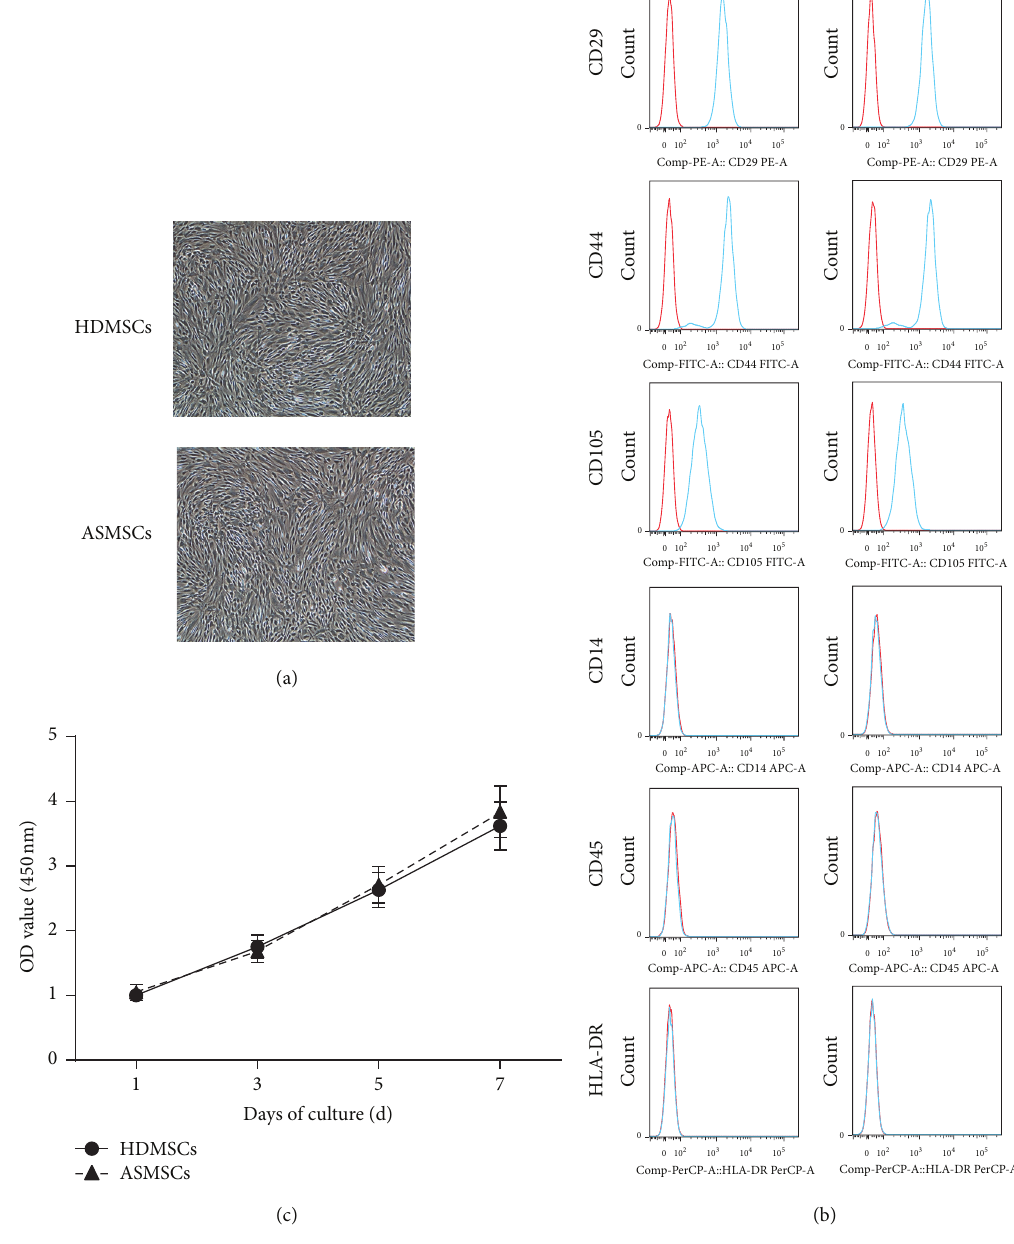
Figure 1: HDMSCs and ASMSCs shared the same morphology, phenotype, and proliferation capacity. (a) Both HDMSCs and ASMSCs were plastic-adherent and spindle-shaped. (b) Both HDMSCs ( 𝑛 = 28 ) and ASMSCs ( 𝑛 = 22 ) were positive for CD29, CD44, and CD105 and negative for CD14, CD45, and HLA-DR, suggesting a typical MSC phenotype. (c) The proliferation capacities of HDMSCs ( 𝑛 = 28 ) and ASMSCs ( 𝑛 = 22 ) were similar when cultured in DMEM with 10% FBS from 1 to 7 days. Optical density (OD) values are presented as the mean ±